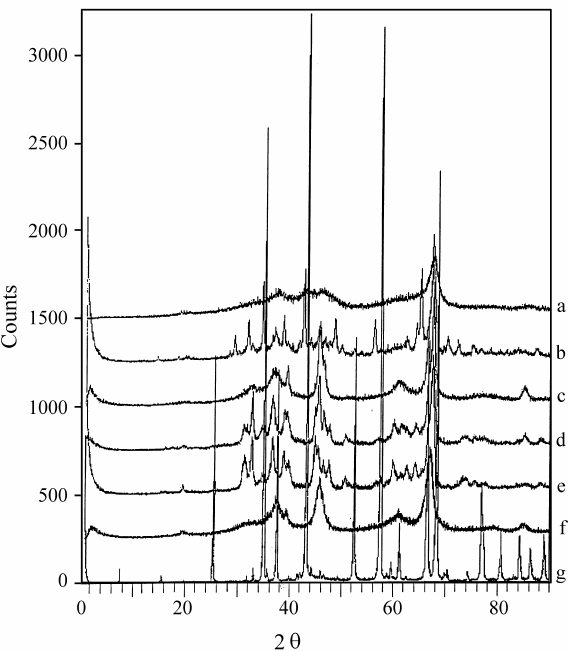
Figure 2. X-ray diffraction powder curves of: (a) chi-Al 2 0 3 ; (b) kappa- Al 2 0 3 ;(c)gamma-Al 2 0 3 ;(d)delta-Al 2 0 3 ;(e)theta-Al 2 0 3 ;(f)eta-Al 2 0 3 ;(g) α -Al 2 0 3